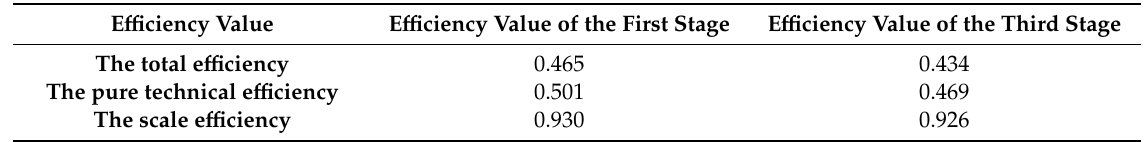
Table 5. E ffi ciency values of the first and third